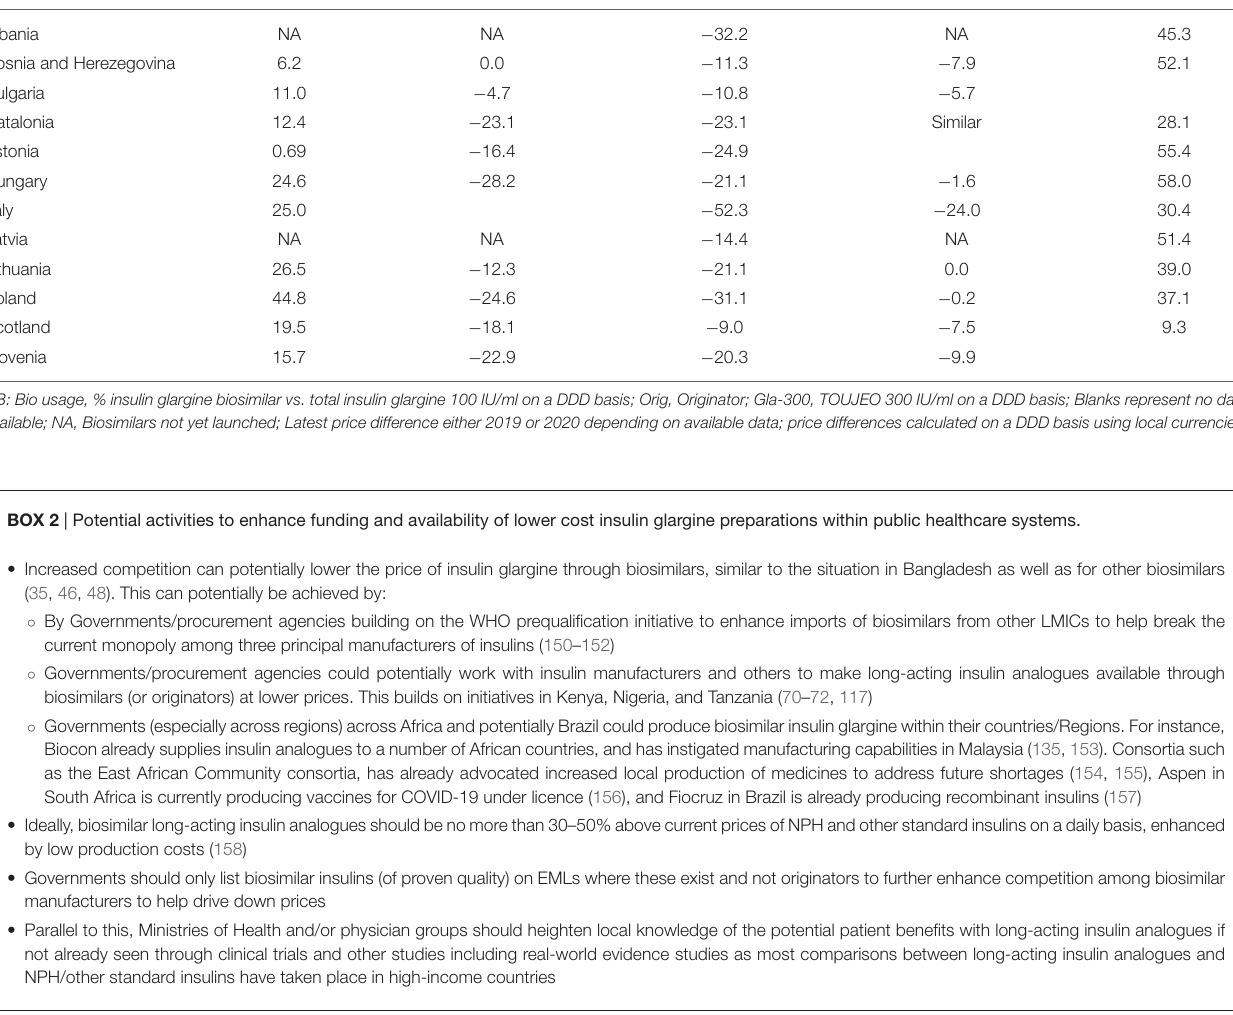
Bio Usage (%) Price difference at